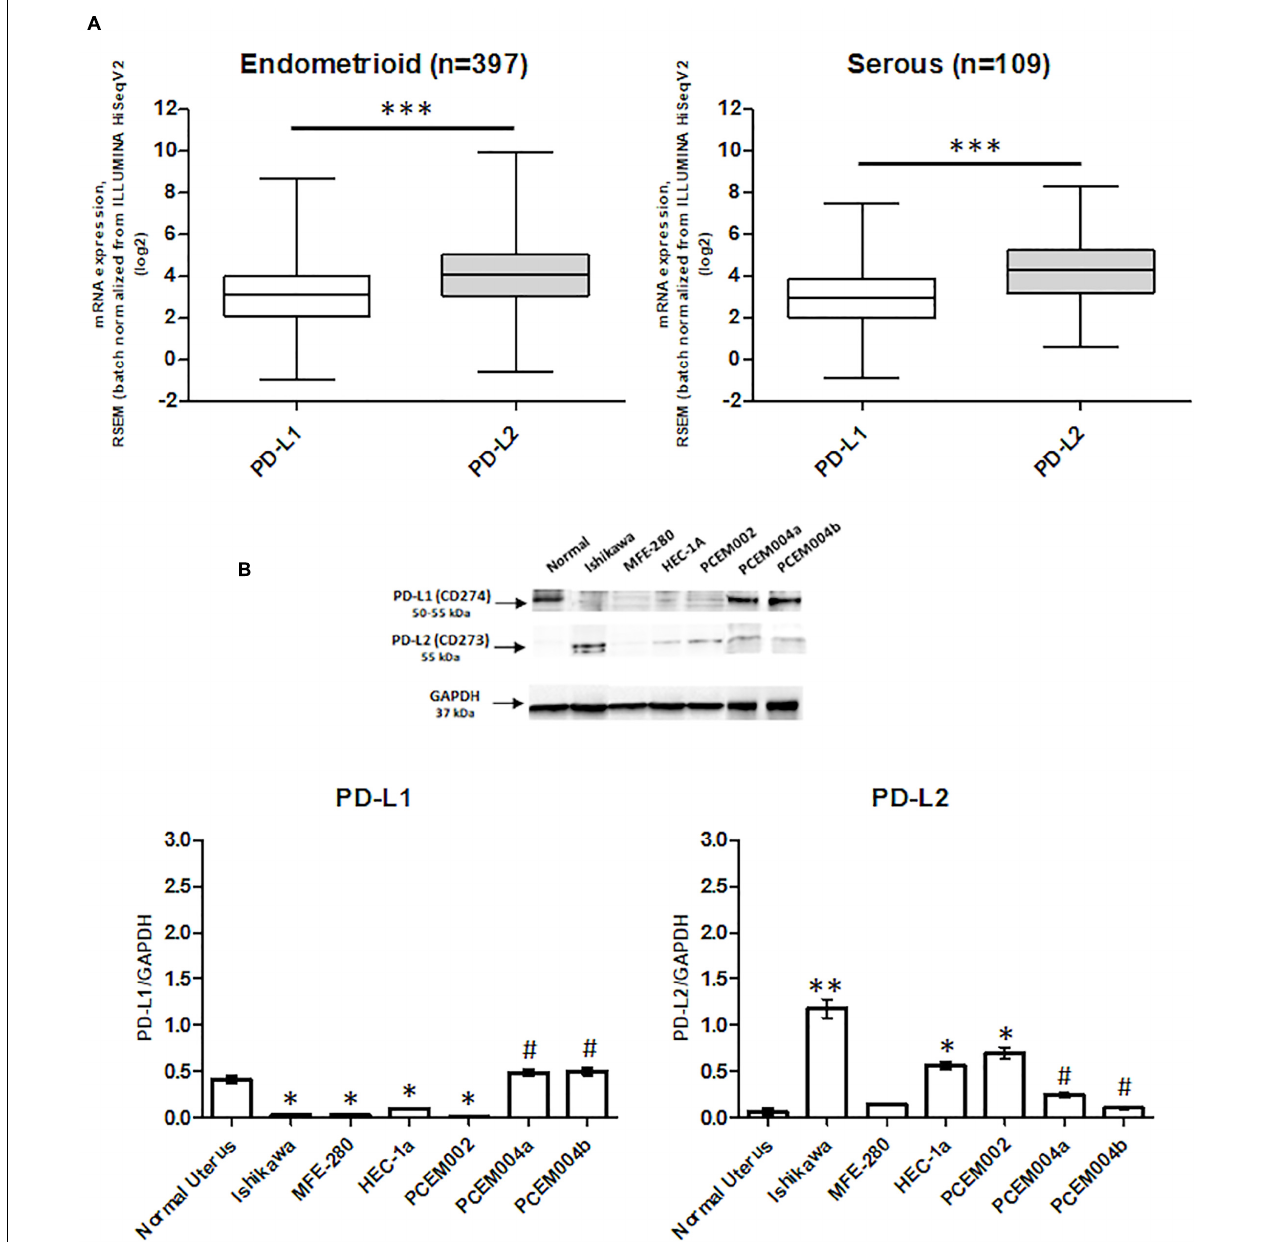
FIGURE 1 | Programmed death-ligand 1 (PD-L1) and PD-L2 expression in endometrial cancer (EC). (A) The expression of PD-L1 and PD-L2 in EC patients. The mRNA expression (log2) of PD-L1 and PD-L2 in 506 EC samples, divided by 397 for type I and 109 for type II, from the TCGA database. *** p < 0.0001 PD-L2 vs PD-L1. (B) PD-L1 and PD-L2 protein expression was evaluated by Western blot in normal human uterus and six EC cell lines. PD-L1 and PD-L2 densitometry values were normalized to glyceraldehyde-3-phosphate dehydrogenase (GAPDH) used as loading control. Densitometric values shown are the mean ± SE of three separate experiments. * p < 0.05 vs normal control, # p < 0.05 vs type I primary EC cell line PCEM002.